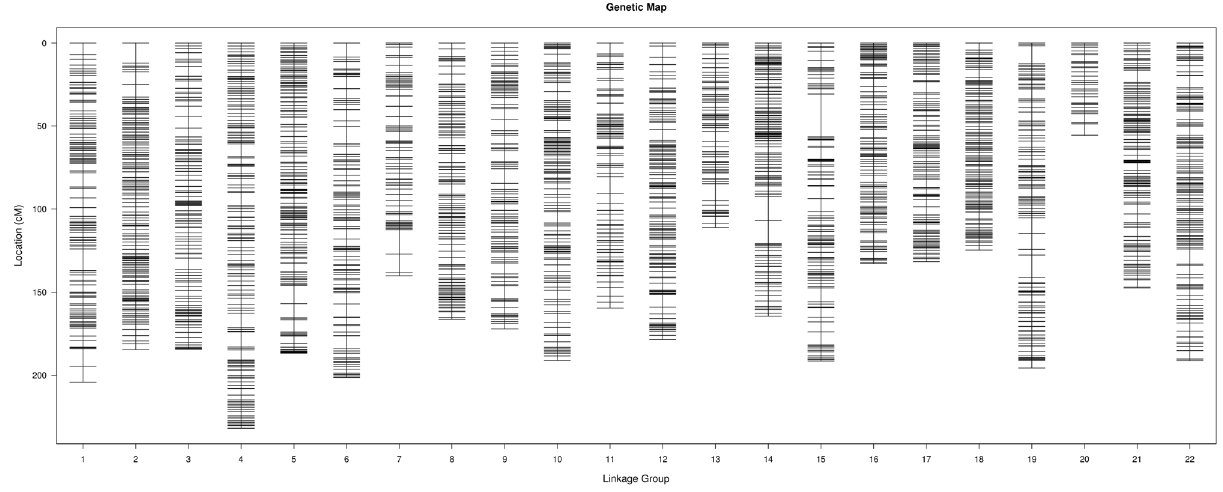
Figure 1. Turbot high-density genetic map.